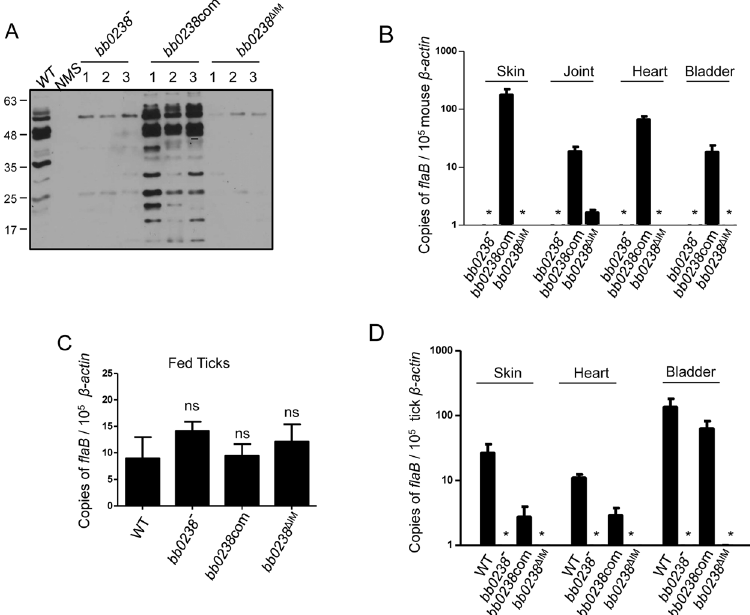
Figure 5. Deletion of the 11-residues of BB0238 that interact with BB0323 impaired spirochete ability to persist in mice or their transmission from infected ticks to naïve hosts. ( A ) Mice (3 animals/group) were infected with bb0238 mutant (bb0238 − ), bb0238 complement (bb0238com) and bb0238 ∆ IM complement (bb0238 ∆ IM ) spirochetes. Sera collected 2 weeks post inoculation was used to screen for immunoblot of B . burgdorferi cell lysate. NMS denotes normal mouse sera, used as a control. ( B ) Spirochete burdens in infected mice were assessed by qRT-PCR, by measuring copies of B . burgdorferi flab gene normalized to mouse β -actin levels in skin, joint, heart and bladder. Error bars represent mean standard errors from three independent experiments. ( C ) Ticks were microinjected with equal numbers of wildtype (WT), bb0238 mutant, bb0238 complement, or bb0238 ∆ IM complemented B . burgdorferi and allowed to engorge on mice (3 animals per group). Spirochete burdens in fully engorged ticks ( C ) and different mice tissues ( D ) were analyzed with qRT-PCR after 2 weeks of infection by measuring copies of flaB normalized against tick or mouse β -actin respectively. Asterisks indicate undetectable levels of bb0238 mutant and bb0238 ∆ IM complement. Statistical significance of differences were analyzed using GraphPad Prism v5. One- or two-tailed Student’s t tests were used to compare the mean values, and p < 0.05 was considered statistically